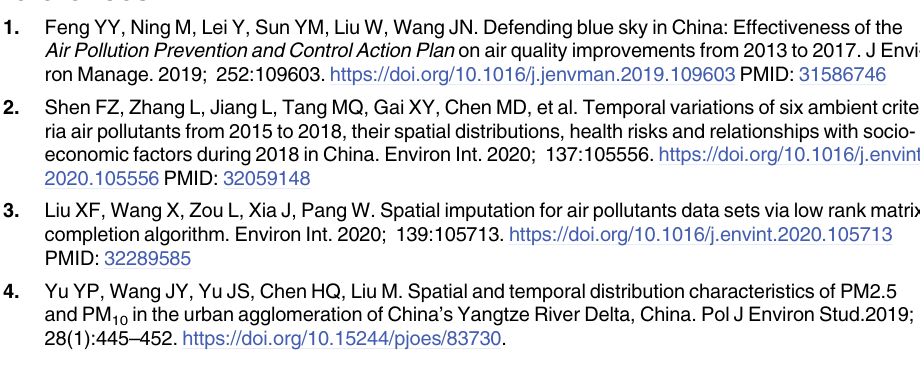
S1 Table. 27 core cities in the YRDUA. S2 Table. Individual characteristics of the STN-AP in the YRDUA. S3 Table. The block classification. S4 Table. The spillover effect between blocks. S5 Table. QAP correlation results of influencing factors on spatial correlation of air pollu- tion. S6 Table. QAP regression results of influencing factors on spatial correlation of air pollu-